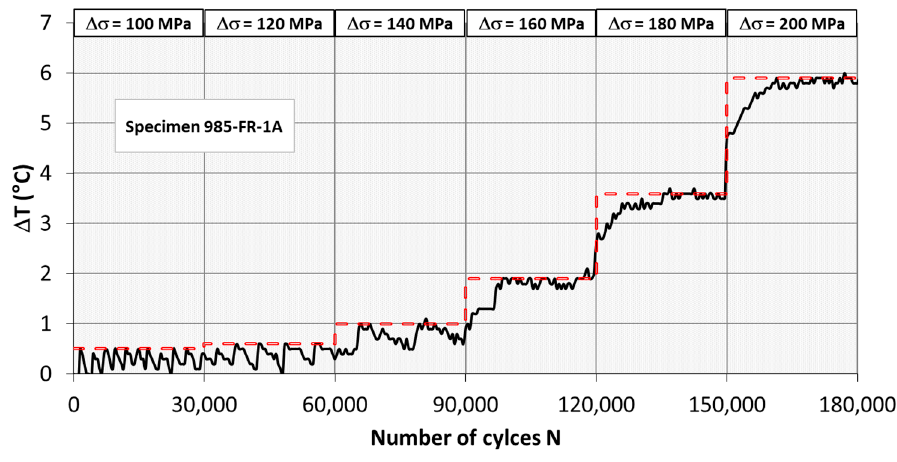
Figure 6. ∆ T-N curve obtained by stepwise load (985-FR-1A specimen, type-NC-4). By plotting the stress range squared ( ∆ σ 2 ) vs. ∆ T AS and performing a linear regression, the fatigue limit can be evaluated by the intersection of the regression straight line with the abscissa axis: this intersection corresponds to the highest stress range for which there is no temperature variation.